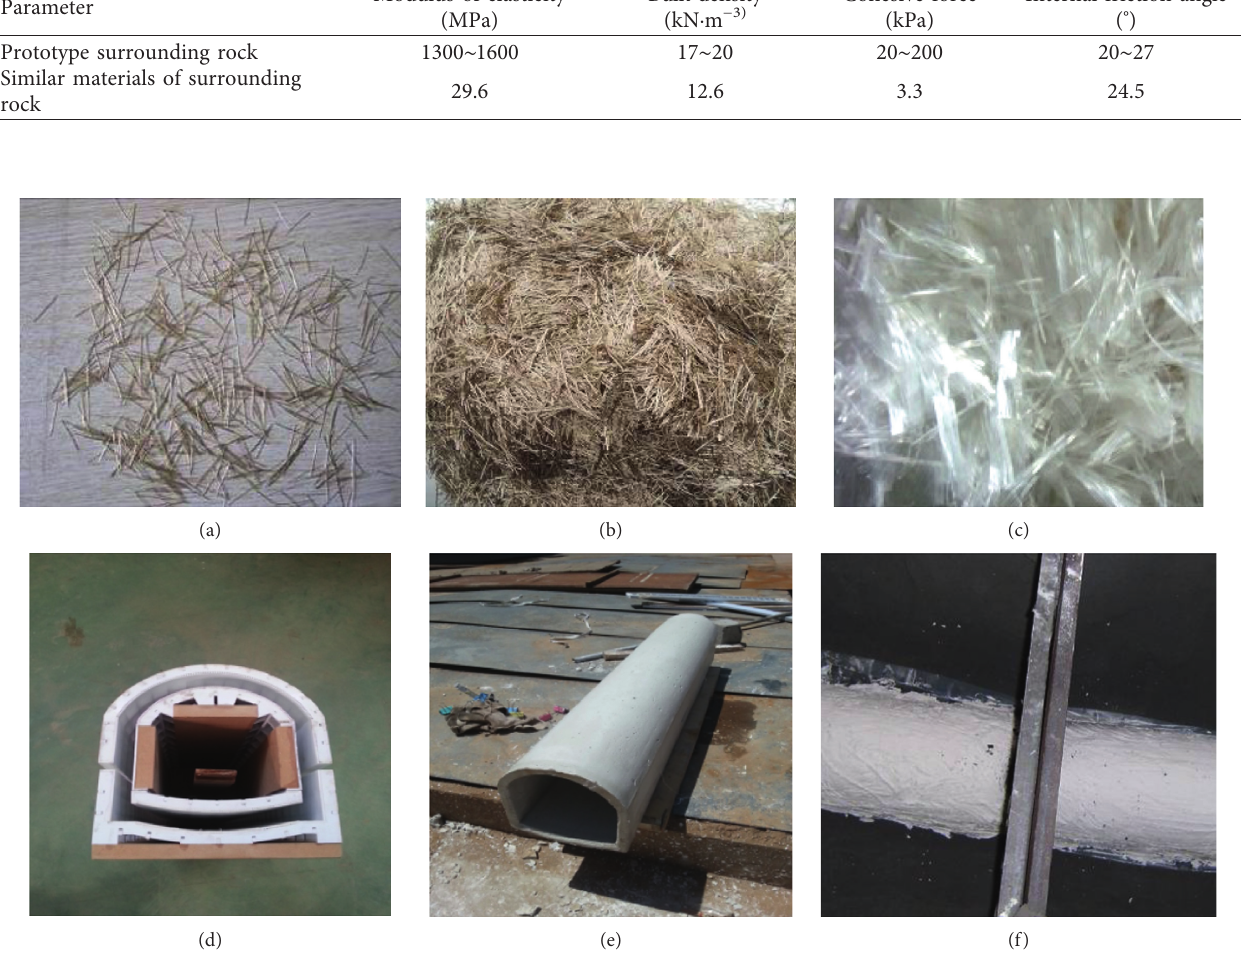
Figure 6: Test similar material and model. (a) Steel fiber. (b) Basalt fiber. (c) Polypropylene fiber. (d) Model casting. (e) Model of lining. (f) Waterproof board and primary